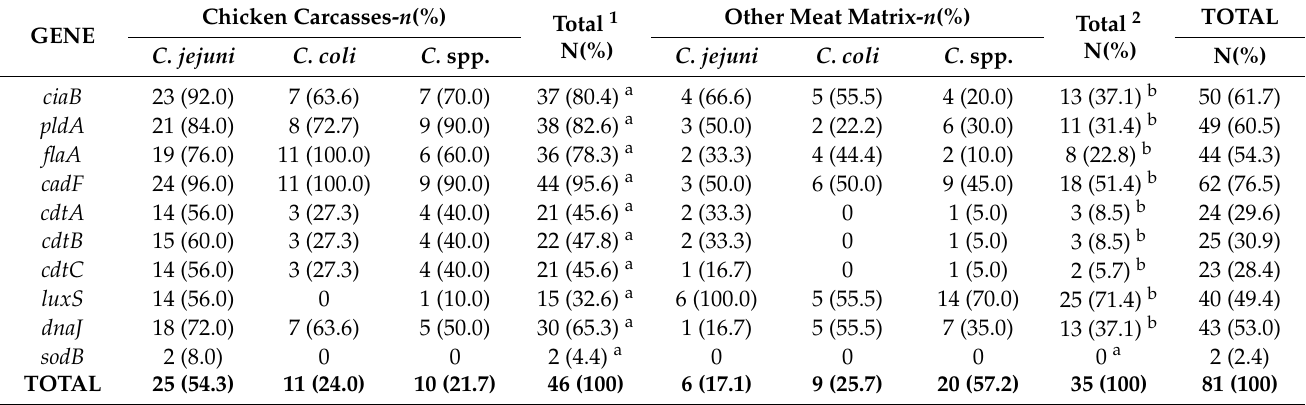
Table 6. Number and percentage of virulence genes in the 81 strains of Campylobacter spp. isolated from meat